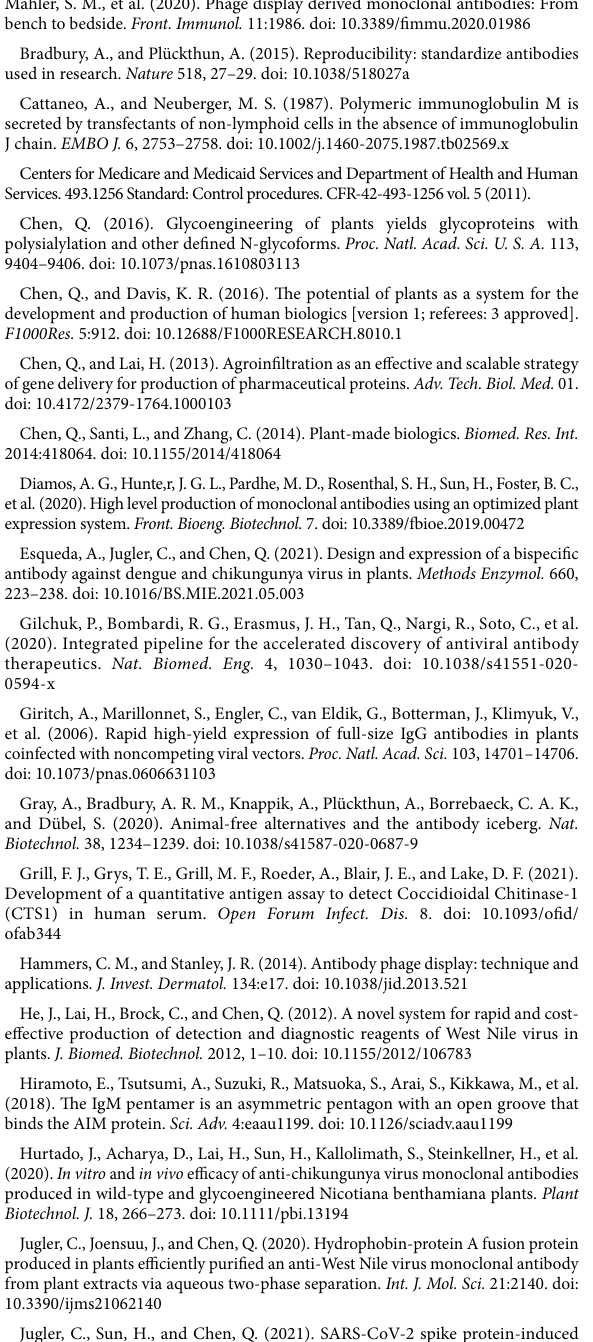
IgG and monomeric IgM is illustrated. MW, molecular weight; bp, base pair. The diagram was created in BioRender.com. SUPPLEMENTARY FIGURE S2 Peptide mapping by mass spectrometry. Tryptic digest of the unexpected bands (between 37 and 50 kDa) in the purified P-4H2 IgM sample was analyzed by LC-ESI-MS/MS. Spectra were searched against a FASTA database of human proteomes (obtained from UniProt) using